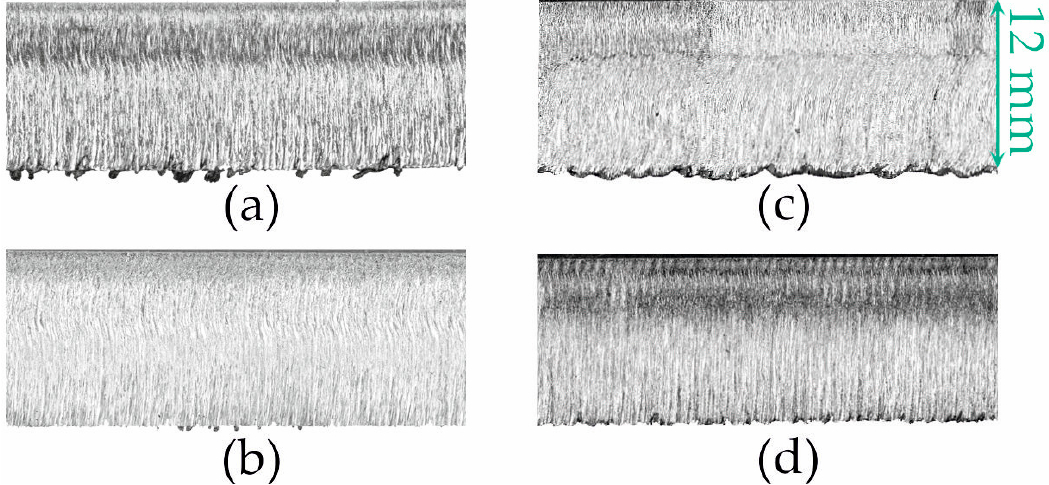
Figure 4. Cut edges of 12 mm stainless steel ( a and b ) and 12 mm mild steel ( c and d ) with static beam shaping ( a and c are references) and longitudinal, linear beam oscillation ( b and d ) with the oscillation parameters marked as star in Figure 3.